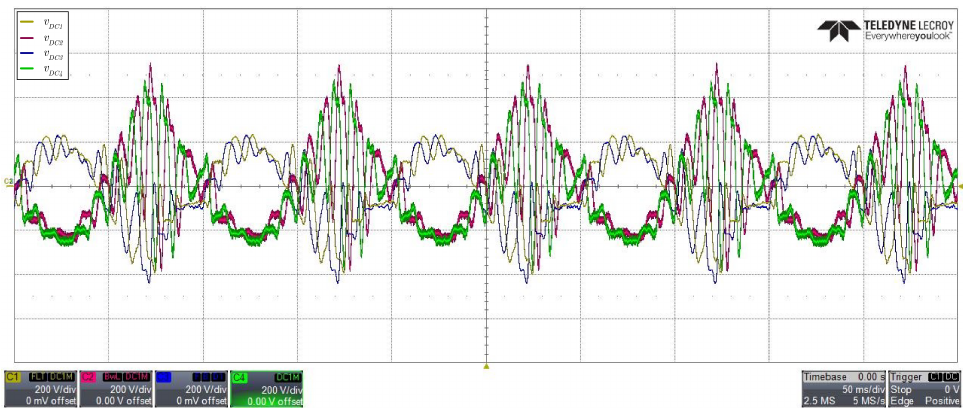
Figure 16. DC voltages from four different sub-modules, considering the operation with reactive